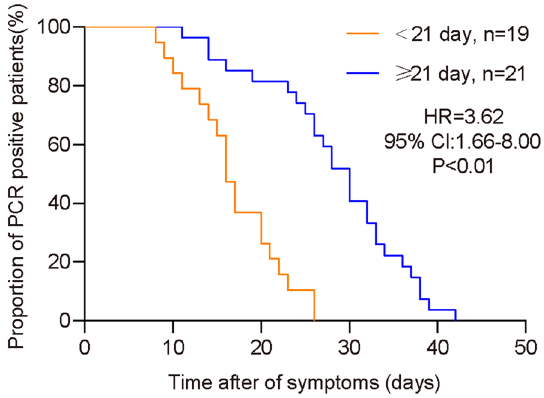
Figure 1. Time to severe acute respiratory syndrome coronavirus (SARS-CoV-2) nucleic acid-negative conversion by PCR analysis of upper respiratory tract samples. CI confidence interval, HR hazard ratio, PCR polymerase chain reaction.